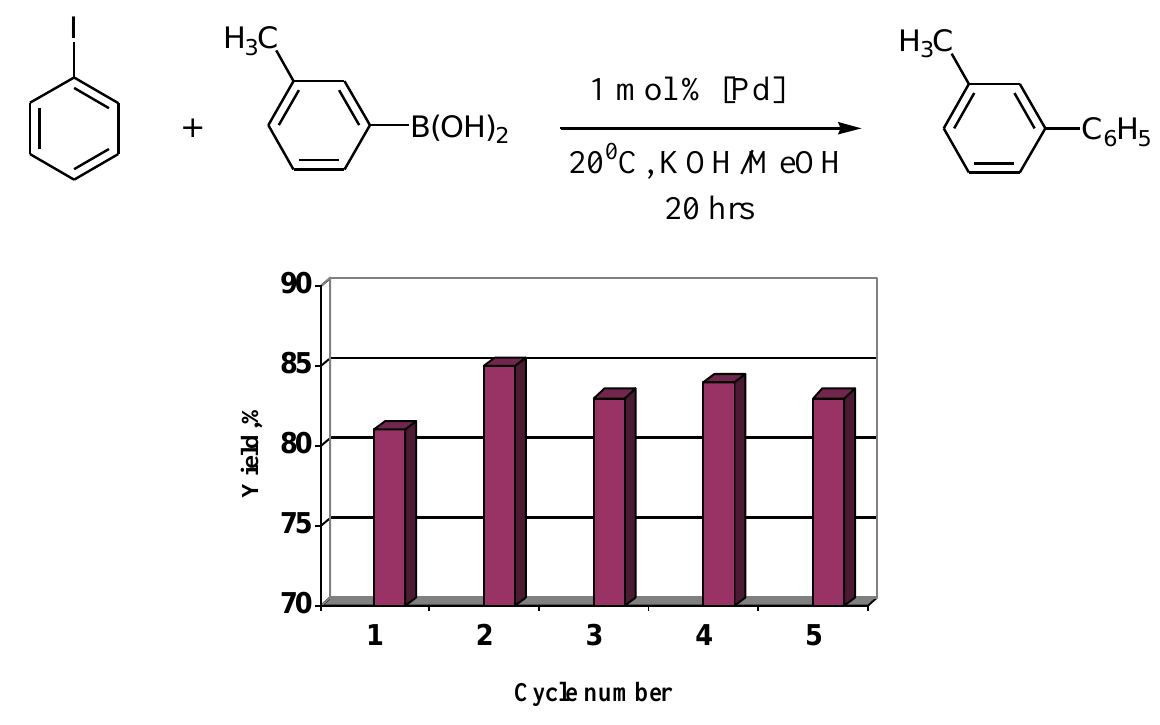
Figure 4. Recycling the catalyst in methanol with use of